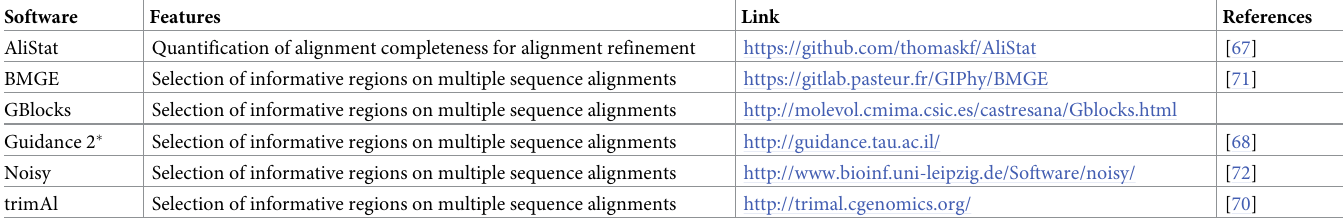
Table 5. List of programs for sequence alignment